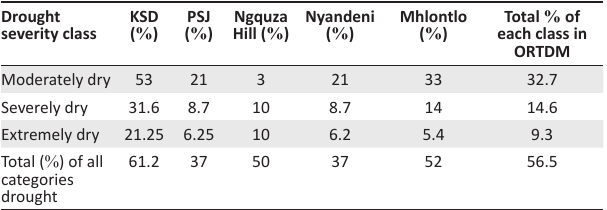
TABLE 3 : Drought severity class table for OR Tambo District Municipality and all its local municipalities for 3 months standardised precipitation index during 1998–2018.